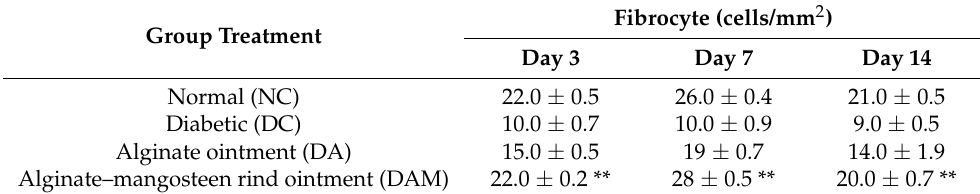
Table 6. Cell counts considering the mean and standard deviation of